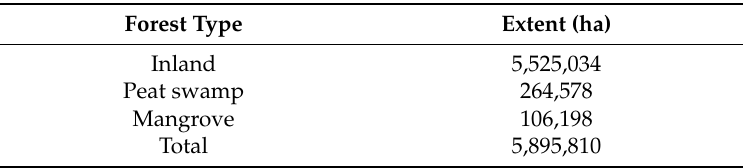
Table 5. Extents of forests in Peninsular Malaysia.